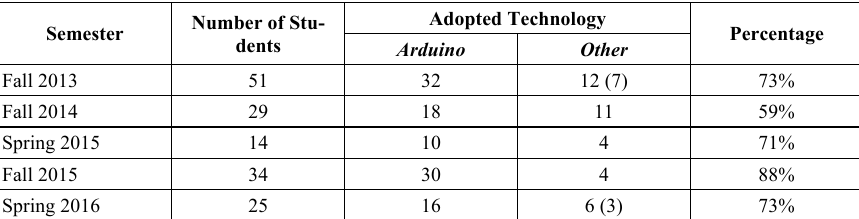
Table 2. Breakdown of used technology in the capstone